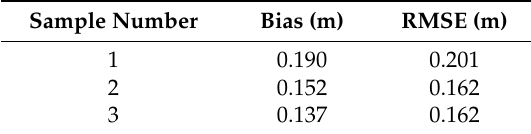
Table 2. Comparisonofthetreepositionextractionresultsbyutilizingimage-basedandfieldmeasurements.